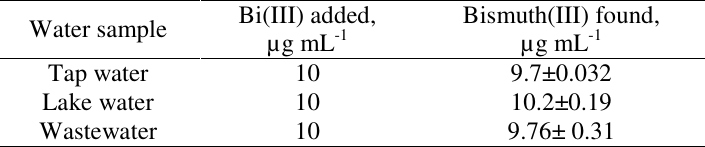
Table 2. Analysis of bismuth(III) different water